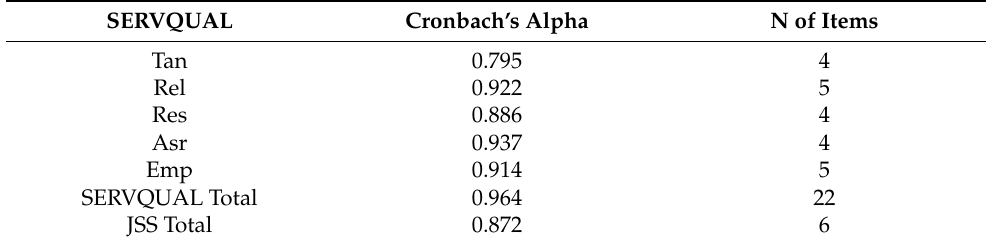
Table 1. Results of the Cronbach’s alpha coefficient.